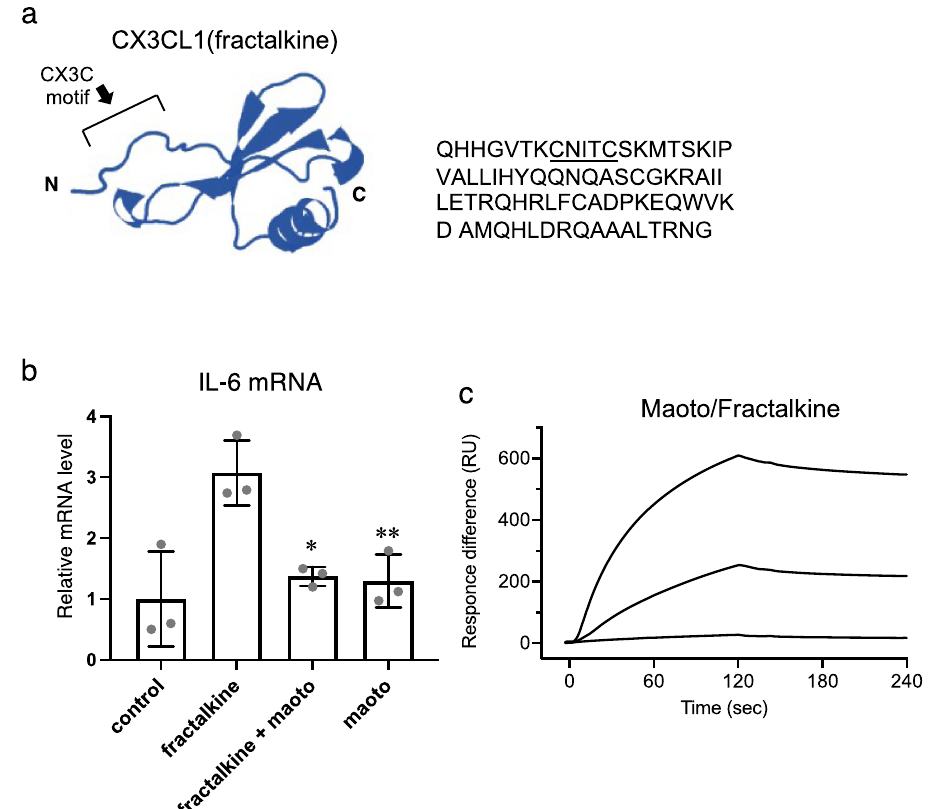
Fig. 5 Interactions between maoto and the CX3C motif. a 3D-structural model of the CXCL1 (fractalkine) chemokine domain. The right column shows the amino acid sequence of the fractalkine chemokine domain (aa 25 – 100). The CX3C motif is underlined. b Induction of IL-6 by fractalkine. A549 cells were primed with PMA (50 ng/mL) and ionomycin (1 µ g/mL) for 4 h, and then treated with fractalkine (100 nM) in the presence or absence of maoto (25 µ g/ mL) for 20 h. Intracellular IL-6 mRNA levels were measured by RT-PCR. The results show individual values and mean ± error bars SD ( n = 3). One-way ANOVA followed by Dunnett ’ s post-test. * P < 0.05 and ** P < 0.01 versus fractalkine alone. c Interaction of maoto with fractalkine immobilized on a sensor chip. Binding was assessed by SPR. Three different concentrations (20, 100 and 200 µ g/mL) of maoto were